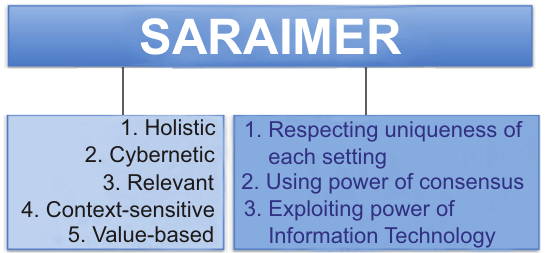
Figure 1. Supporters of Systematic Appraisal of Risk and Its Management for Error Reduction